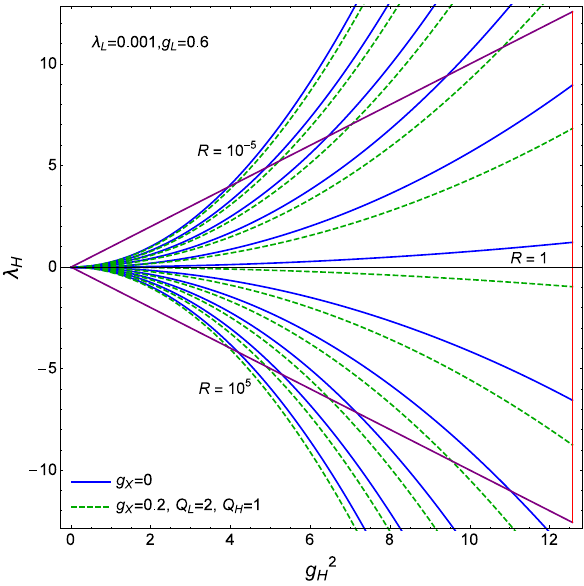
Fig. 1 Illustration of the allowed parameter region in the ( g 2 plane and the lines with constant R for a given value of g L and λ L . For illustration, we show large hierarchies up to R = 10 5 (lower region of the plot) and small hierarchies up to R = 10 − 5 (upper region of the plot), whilethe hierarchy R = 1remains inthe middleof the plot. From top to bottom, each line increases its R value by a factor × 10. The solid blue lines correspond to the results with g X = 0 while the dashed green ones correspond to g X = 0 . 2, Q L = 2 and Q H = 1. The restrictions described in Eq. (5) are also represented for ε CW = ε g 2 = 1: CW restriction (diagonal purple lines) and g 2 max (vertical red line)